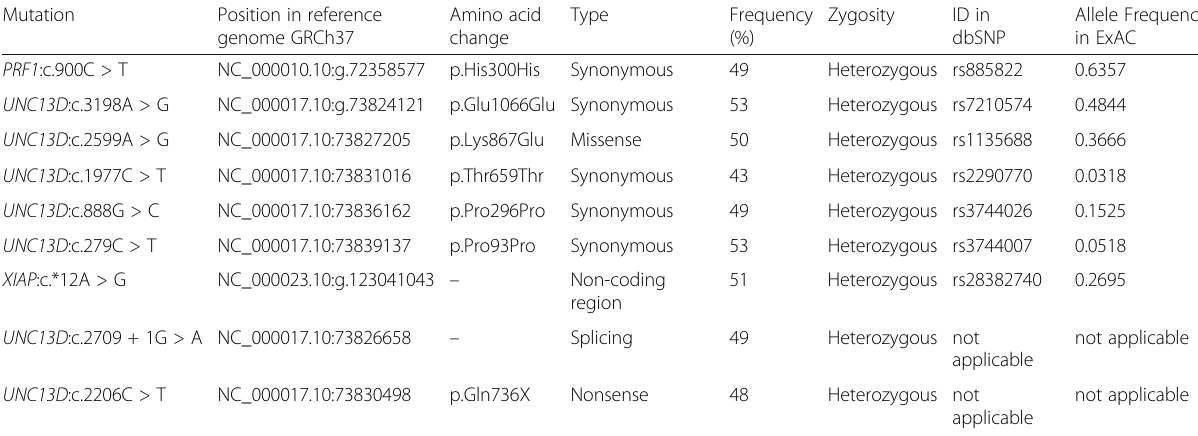
Table 2 Detected variations in the patient with HLH